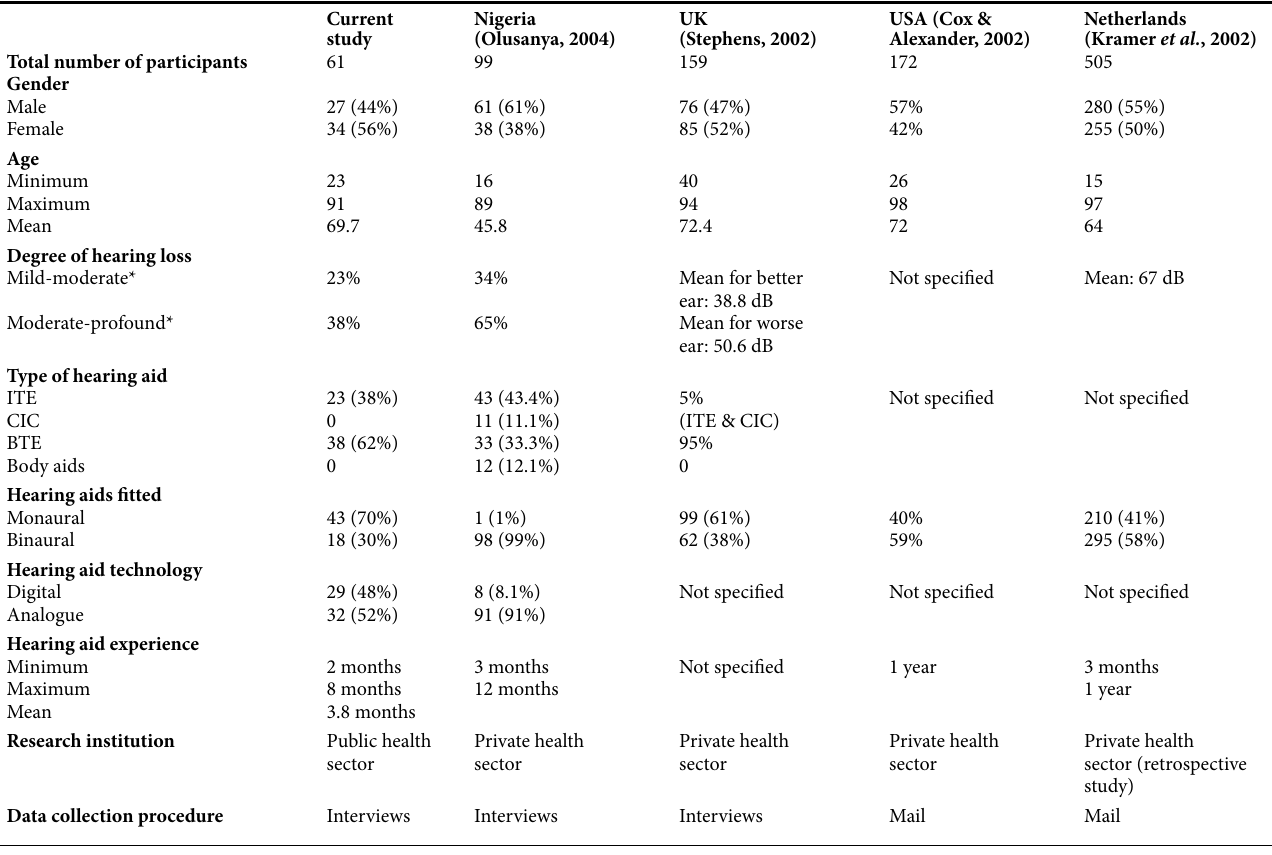
table I. Profile of participants for the current study and for similar reports from other countries